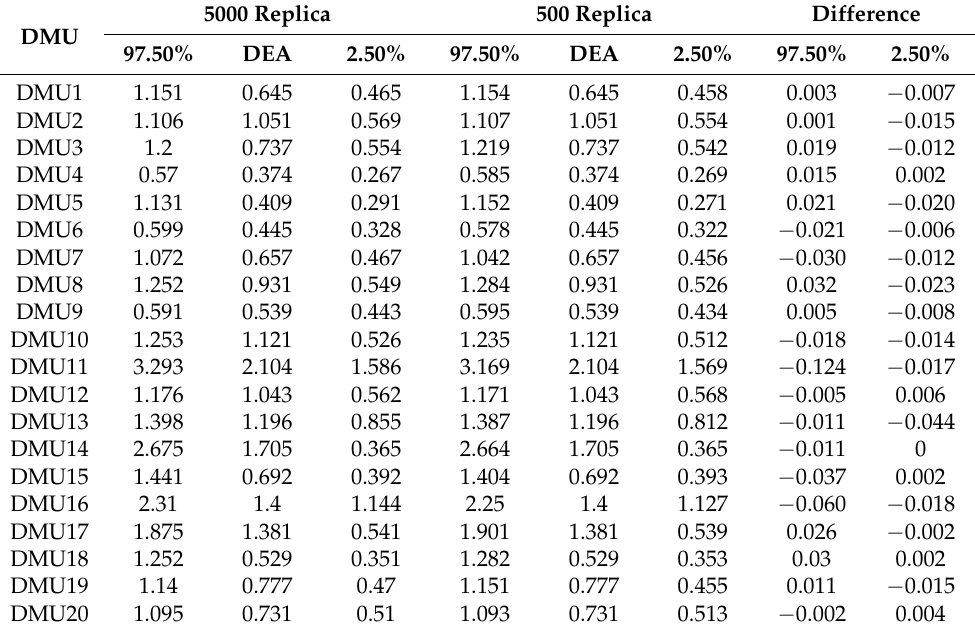
Table 3. Comparisons of 5000 and 500 replicas (Fisher 95%) for the period of 2015 to 2019.